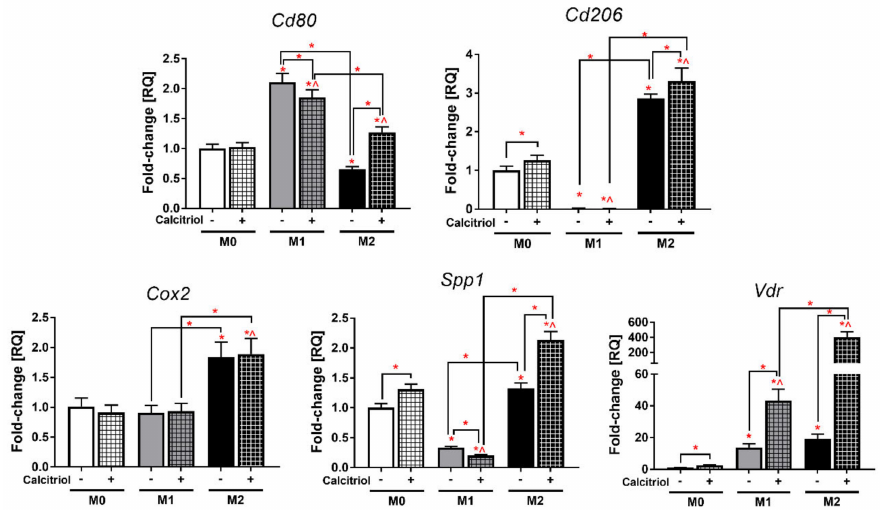
Figure 1. The e ff ect of calcitriol on gene expression in individual classes of bone marrow-derived macrophages (BMDMs) analyzed by real-time PCR. Calcitriol lowers Cd80 and Spp1 expression for M1 BMDMs, increases Cd80 expression for M2 BMDMs and Cd206 and Spp1 for M0 and M2 BMDMs, and increases Vdr expression in all BMDMs classes. The level of gene expression is presented in relation to the results obtained for M0 BMDMs (unstimulated and untreated with calcitriol). Briefly, RNA was isolated, purified, and transcribed into cDNA. Real-time PCR was performed using Taq-Man chemistry. A single reaction was performed with 50 ng of cDNA and each sample was performed in technical triplicates. The relative quantification (RQ) level of examined gene expression, referred to as fold change, was calculated based on the di ff erences in ∆∆ Ct values of the studied genes in relation to the control housekeeping gene Hprt1 . Data presentation: mean with standard deviation. Number of independent repetitions = 3 (BMDMs cultures generated from three mice). Statistical analysis: Sidak’s or Dunn’s multiple comparisons test. * p < 0.05 as compared to M0, ˆ p < 0.05 as compared to M0 + cal or as